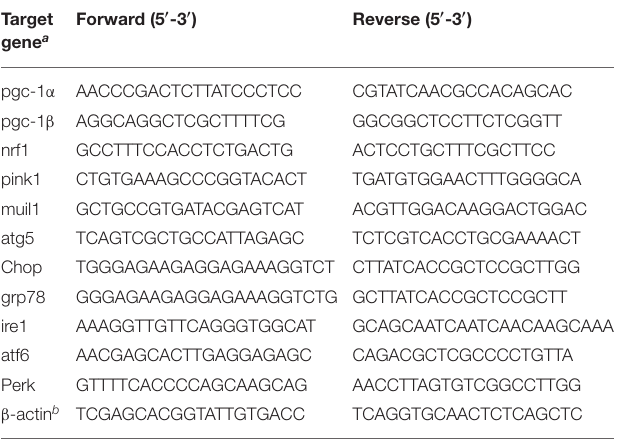
TABLE 2 | Sequences of primers used for RT-qPCR. Target Forward (5 ′ -3 ′ ) gene a